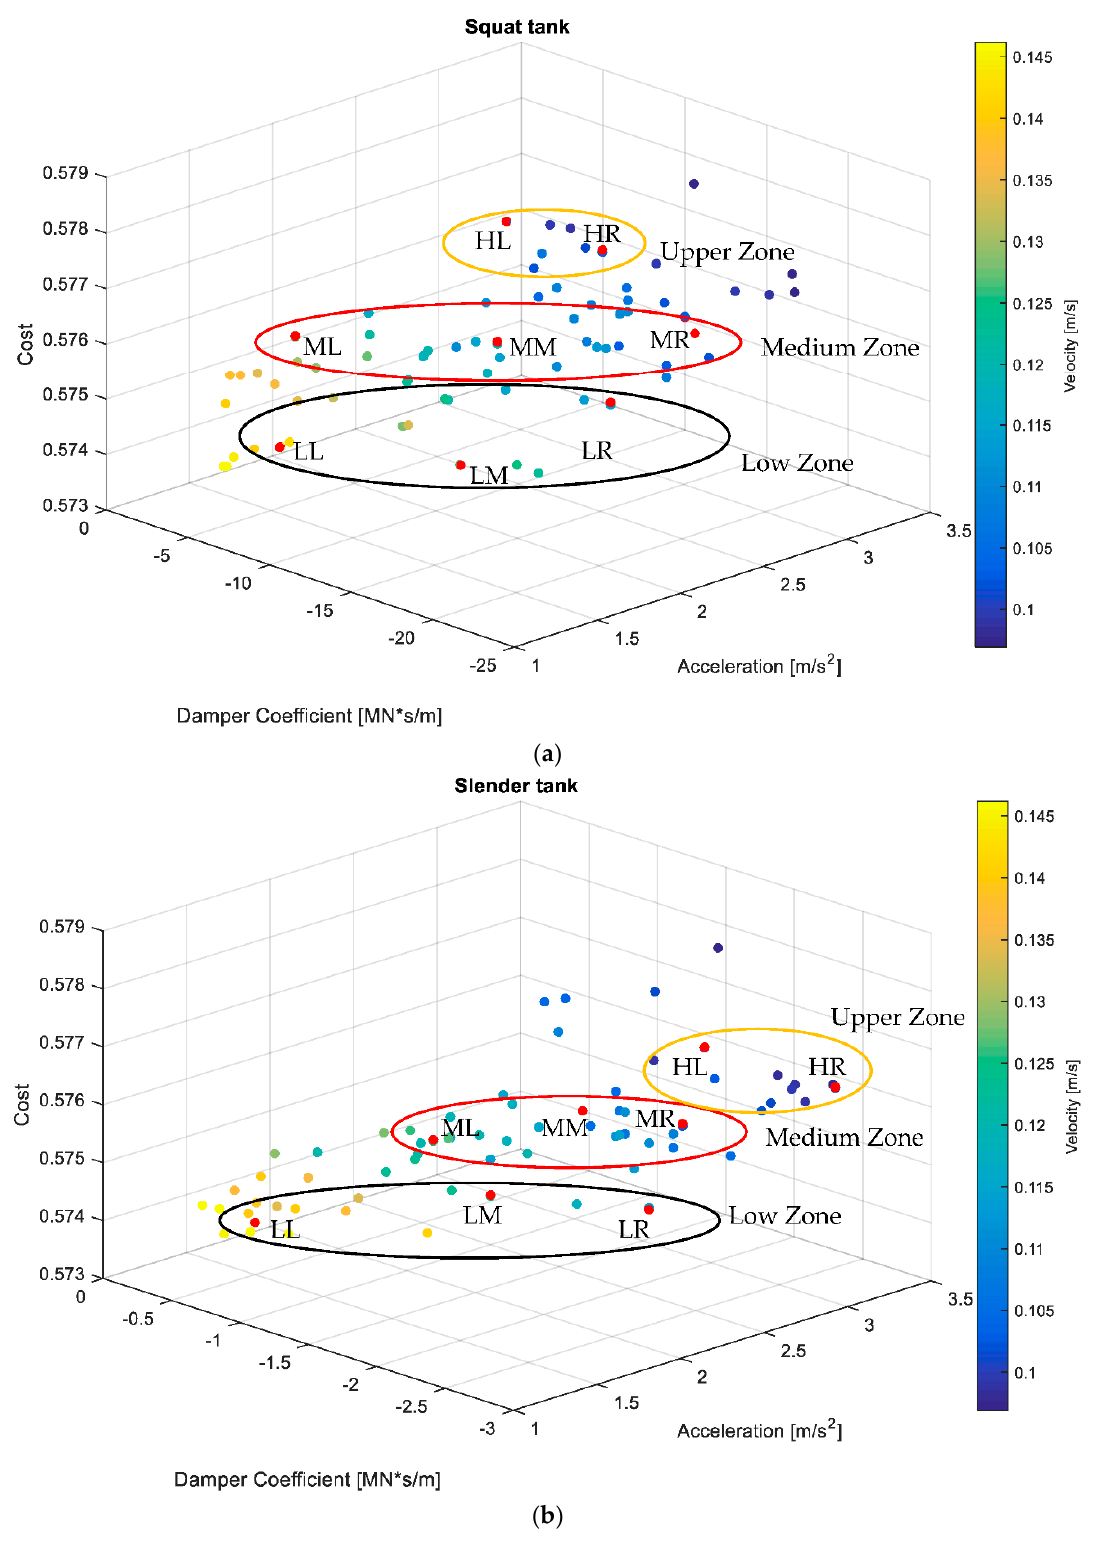
Figure 7. Pareto front results of MOGA2 formulation for: ( a ) the squat and ( b ) slender tank.